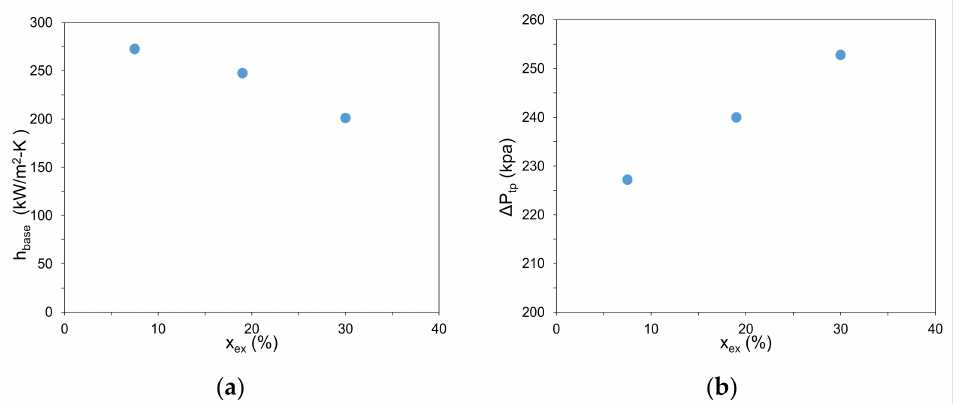
Figure 5. ( a ) Base heat transfer coefficient and ( b ) pressure drop of the cryogenic micro-pin fin cooler as a function of exit